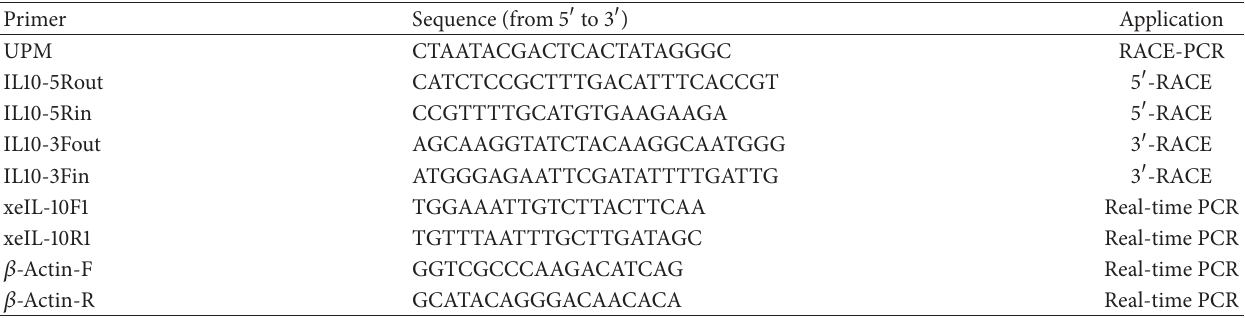
Table 1: Primers used in the